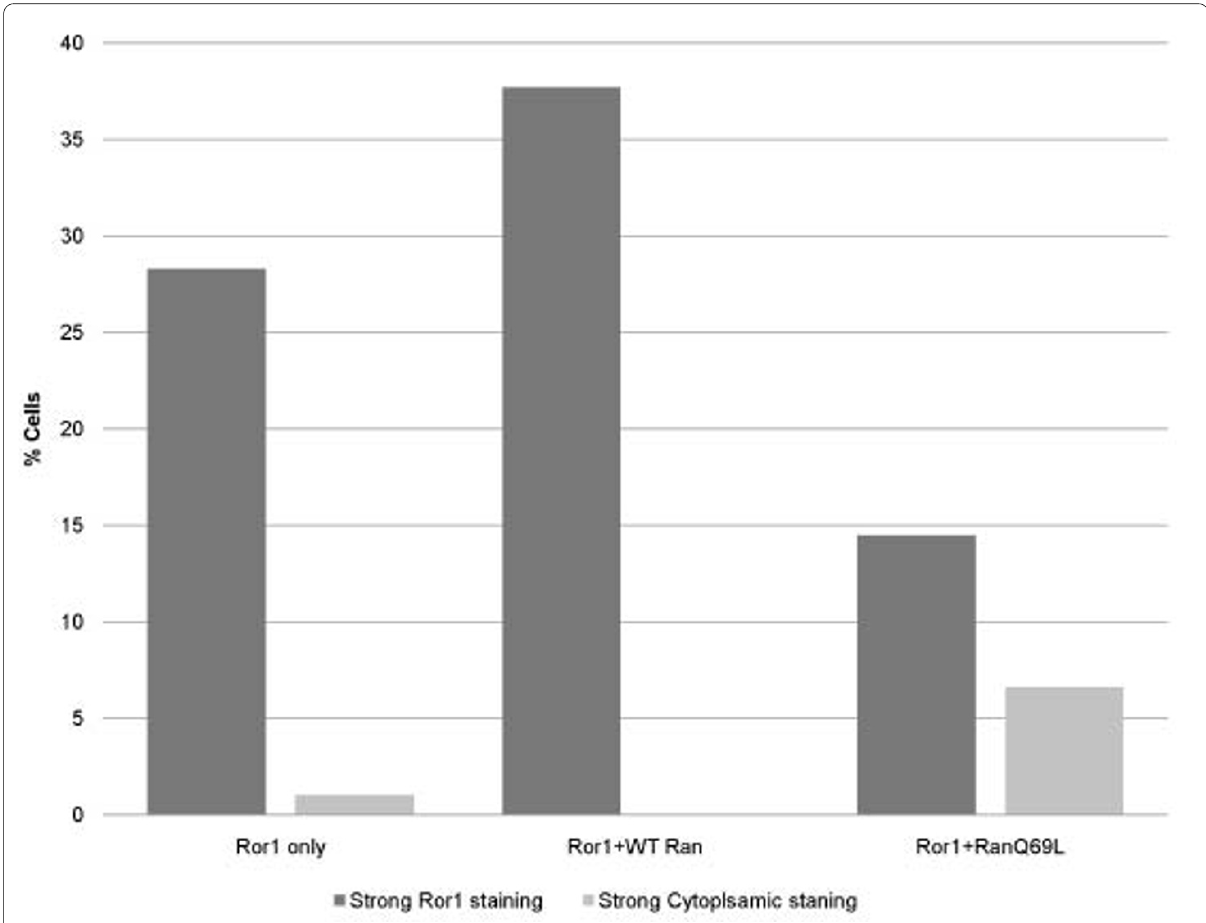
Figure 6 Quantification of Ror1 localization in transfected cells . The localization pattern of Ror1 in cells expressing the indicated Ror1 and Ran constructs was scored for 80 cells. The graph shows the percentage of cells with the indicated Ror1 localization